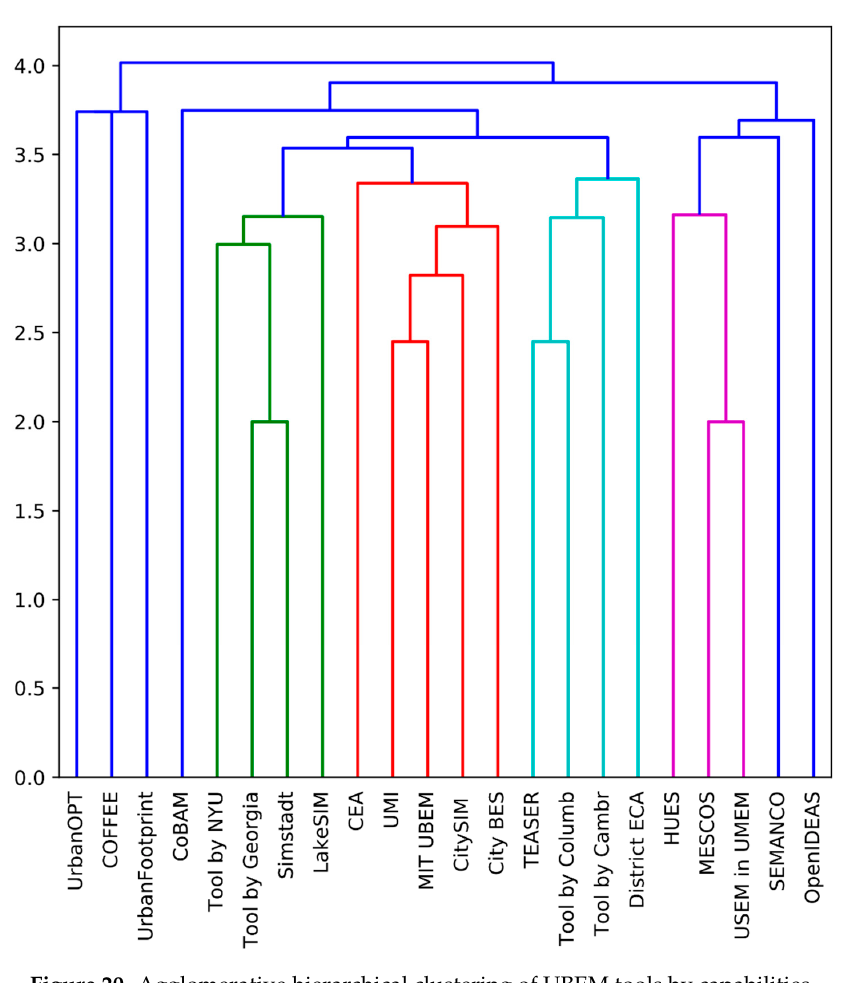
Figure 20. Agglomerative hierarchical clustering of UBEM tools by capabilities.